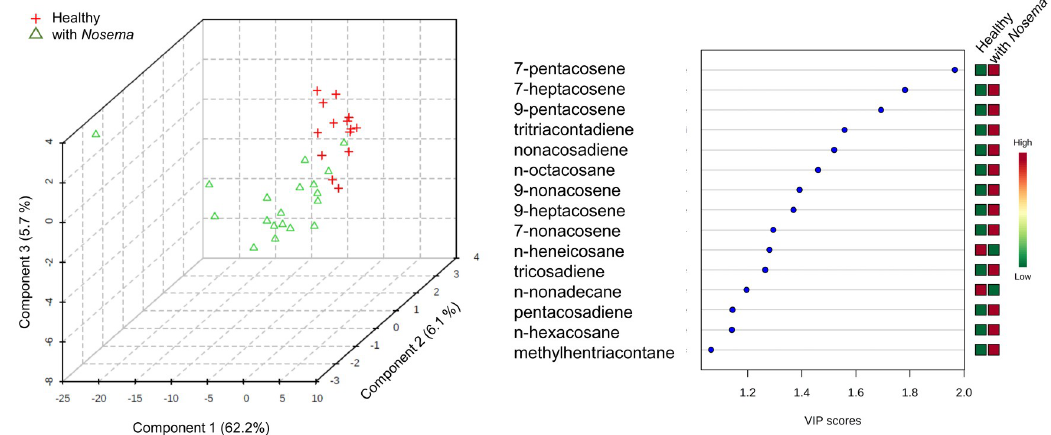
Fig 7. Multivariate analysis of CHC from healthy and Nosema -infected honeybees: 3-D scores plot ( A ) between selected components corresponding to a PLAS-DA run on samples form healthy and Nosema –infected bees. The explained variances are shown in brackets. The model was validated (number of components needed, 5; performance: R2 = 0.81; Q2 = 0.32, permutation test p = 0.002). Important features (VIP > 1) found by PLS-DA ( B ): colored boxes on the right indicate the relative concentrations of the corresponding metabolite in each group under